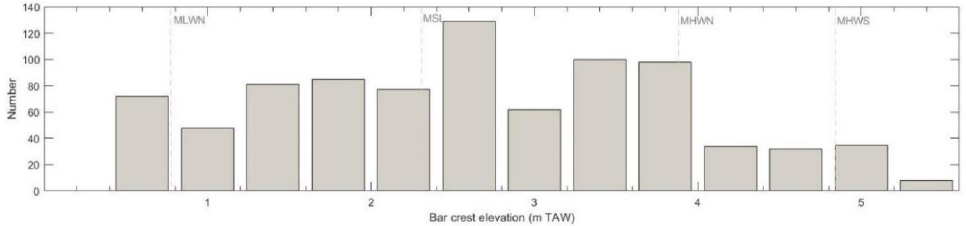
Figure 7. Frequency distribution of bar crest elevation. The number corresponds to the total detected bars of all the surveys (n = 861, total number). The vertical dashed lines correspond to the tidal levels. The mutual correlations between morphometric parameters characterizing the bar morphology are presented in Figure 8. The mean height of the bar was 1.8 m on the upper-intertidal beach above MHWS level and considerably less (0.2 m) on the lower part of the intertidal zone below MLWN level. It appears that there is a relatively diffuse and linear increase in the bar height trend toward the land (R 2 = 0.57). Another positive correlation is found between the bar elevation and the seaward slope (R 2 = 0.47), so that the inner bars located on the upper-intertidal beach are more likely to have